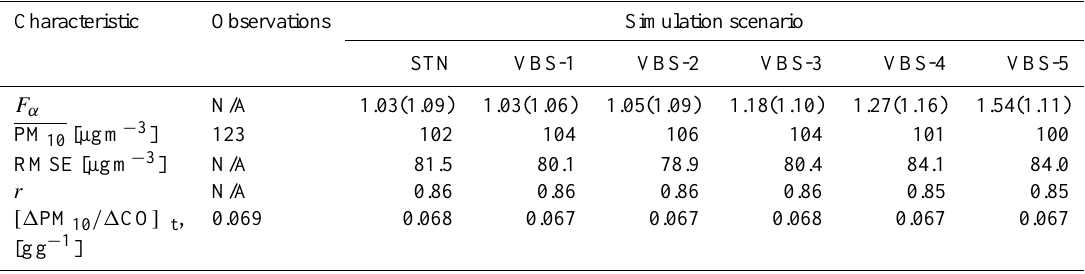
Table 4. Characteristics of the simulation data (after bias correction) compared to air pollution measurements at monitoring stations in the Moscow region. F α are the optimal estimates for the fire emission correction factor (see Eq. 4) derived from PM 10 data; the geometric SD characterizing uncertainties in F α are given in parentheses. PM 10 is the mean PM 10 concentration over the study period. [ (cid:49) PM 10 /(cid:49) CO ] fit is the normalized excess mixing ratio evaluated as the slope of a linear fit to the relationship between perturbations of CO and PM 10 concentrations due to fire emissions on days affected by fires (see also Fig. 7).